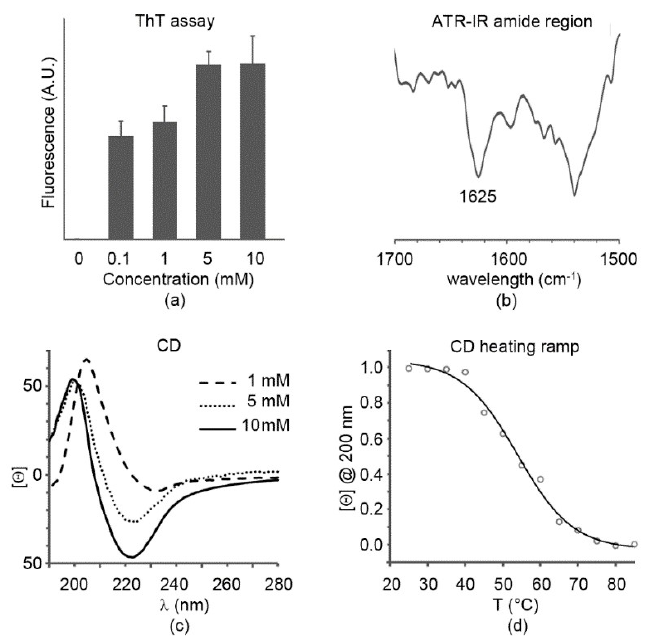
Figure 2. Peptide secondary structure. ( a ) Thioflavin T fluorescence assay; ( b ) attenuated total reflectance infrared (ATR-IR) amide region at 10 mM; ( c ) circular dichroism (CD) spectra; ( d ) CD heating ramp revealing a T m = 54 °C at 10 mM.